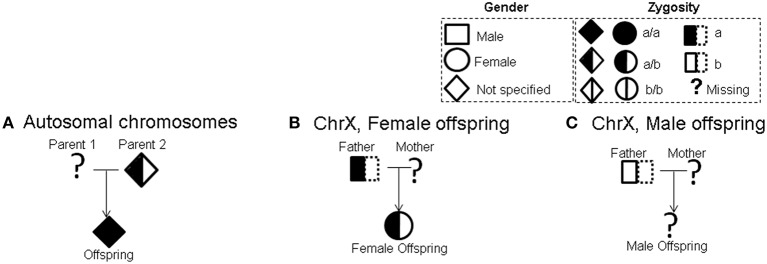
Examples of admissible incomplete trios. (A) Autosomal chromosomes (B) X chromosome (female offspring) (C) X chromosome (male offspring). CIFBAT considers all valid completions of incomplete trios in the data as equally likely. Using randomly selected completions over several repetitions, CIFBAT computes a quantile interval of the FBAT statistic.